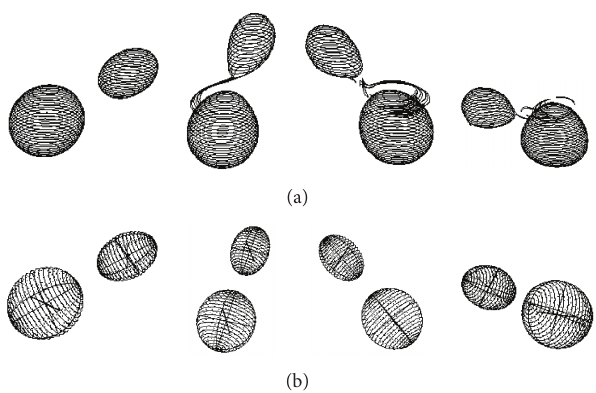
Figure 1: The time evolution of two like-signed vortices solved using contour dynamics solution of the full QG equations (a) and using the ellipsoidal model (b). The side view is from an angle of 60 degrees. Figures courtesy of http://www-vortex.mcs.st-and.ac.uk/ ∼